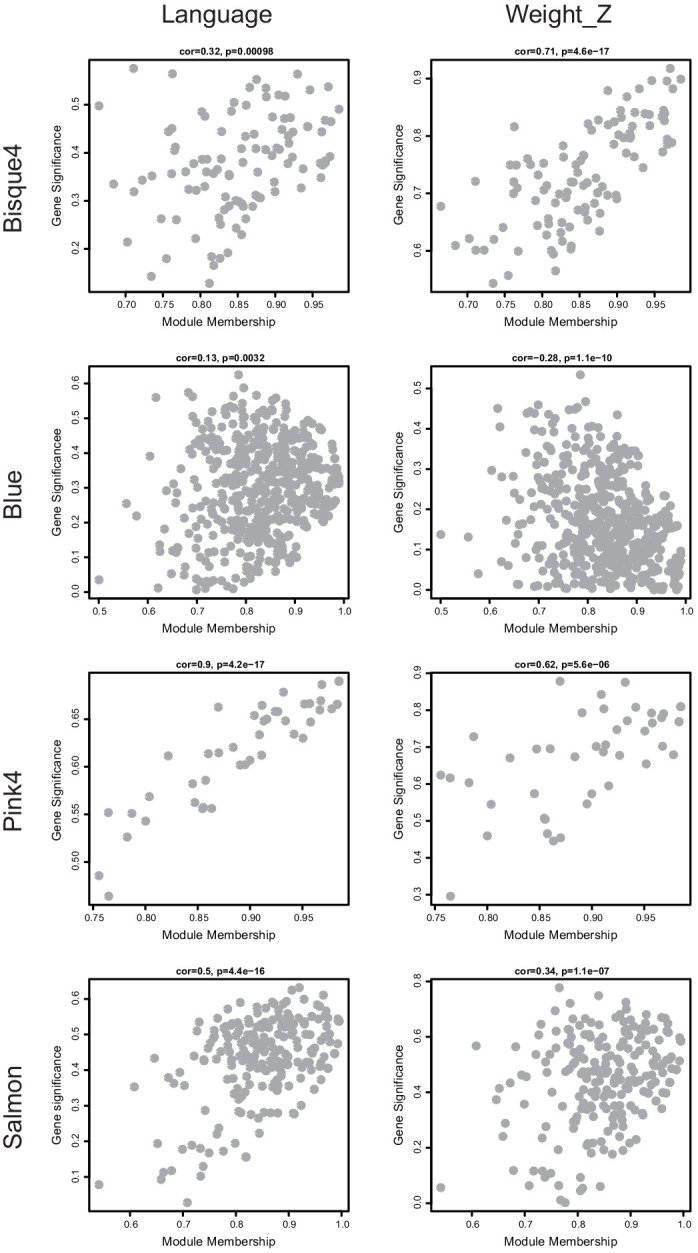
Visualization of module membership (MM) and gene-trait significance (GS) for modules with statistical significance.Scatterplots depicting the relationship between MM and GS for member genes of modules of interest. Significance relative to the trait Weight_Z (left column) and Language (right column) are displayed. The MM-GS correlation and significance reported by WGCNA are depicted on each plot.